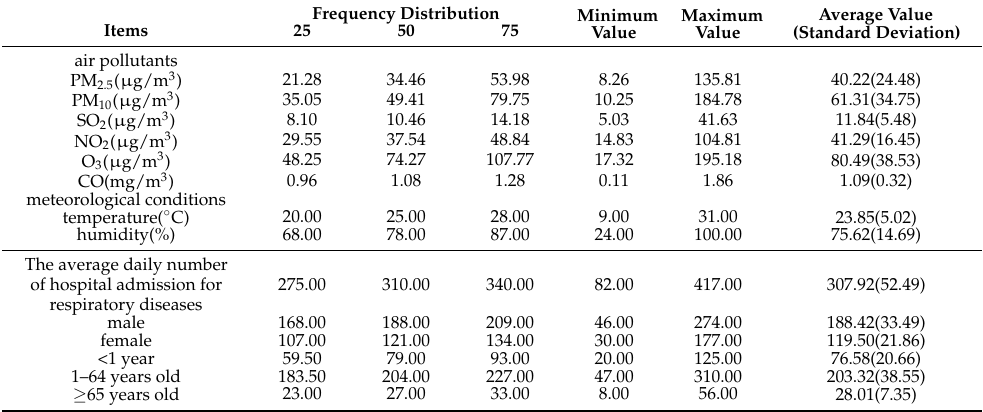
Table 1. Descriptive statistics of air pollutants, meteorological conditions, and